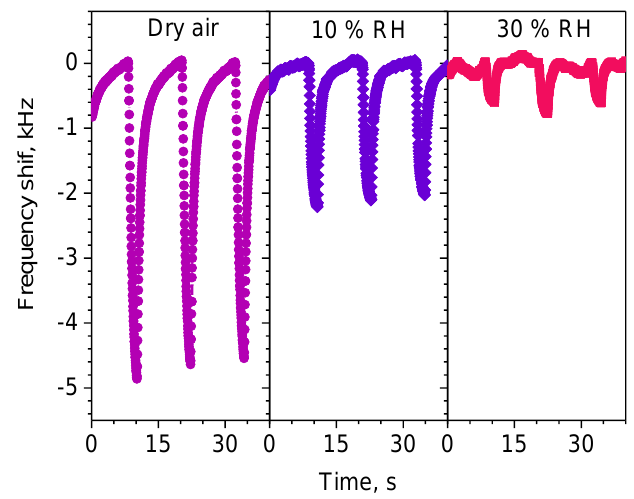
Figure 6. Frequency response of Ag/PPy L-SAW sensor to acetone concentration of 5 ppm under dry air, 10% and 30% relative humidity (RH).